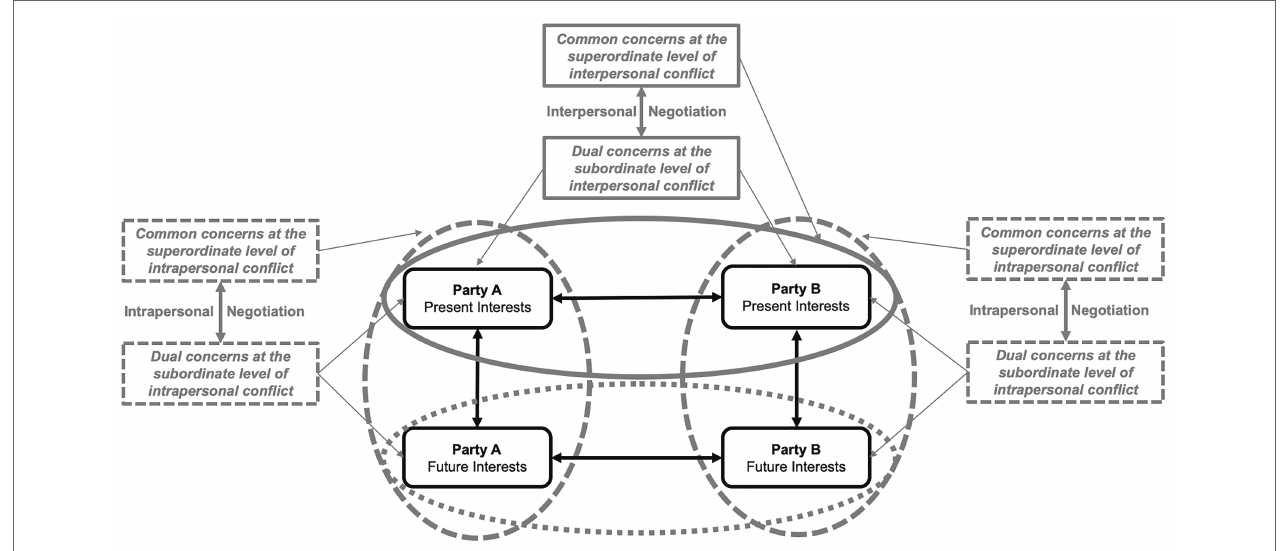
FIGURE 3 | The negotiation-with-oneself strategy for balancing the consideration of interdependent conflicts at the individual level. The horizontal ellipses show how common concern can lead to integrative negotiation processes between parties. The vertical ellipses show how common concern can lead to integrative negotiation processes over